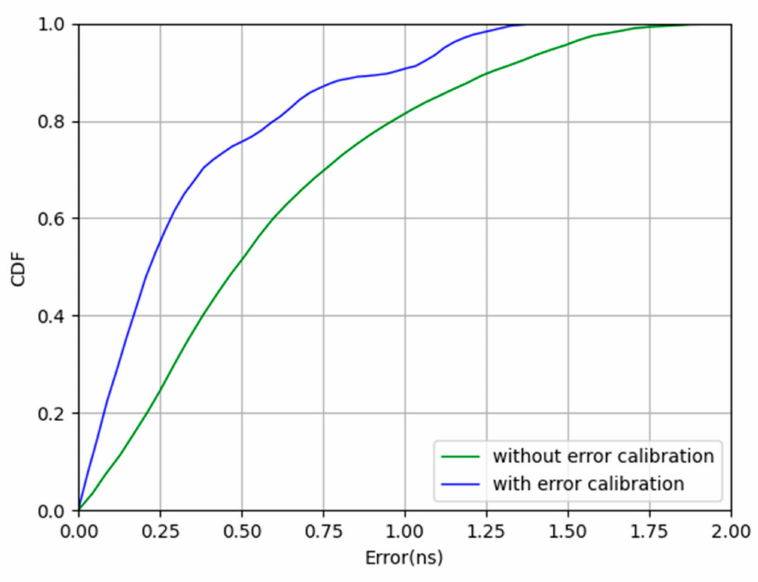
Figure 7. Time synchronization with and without error